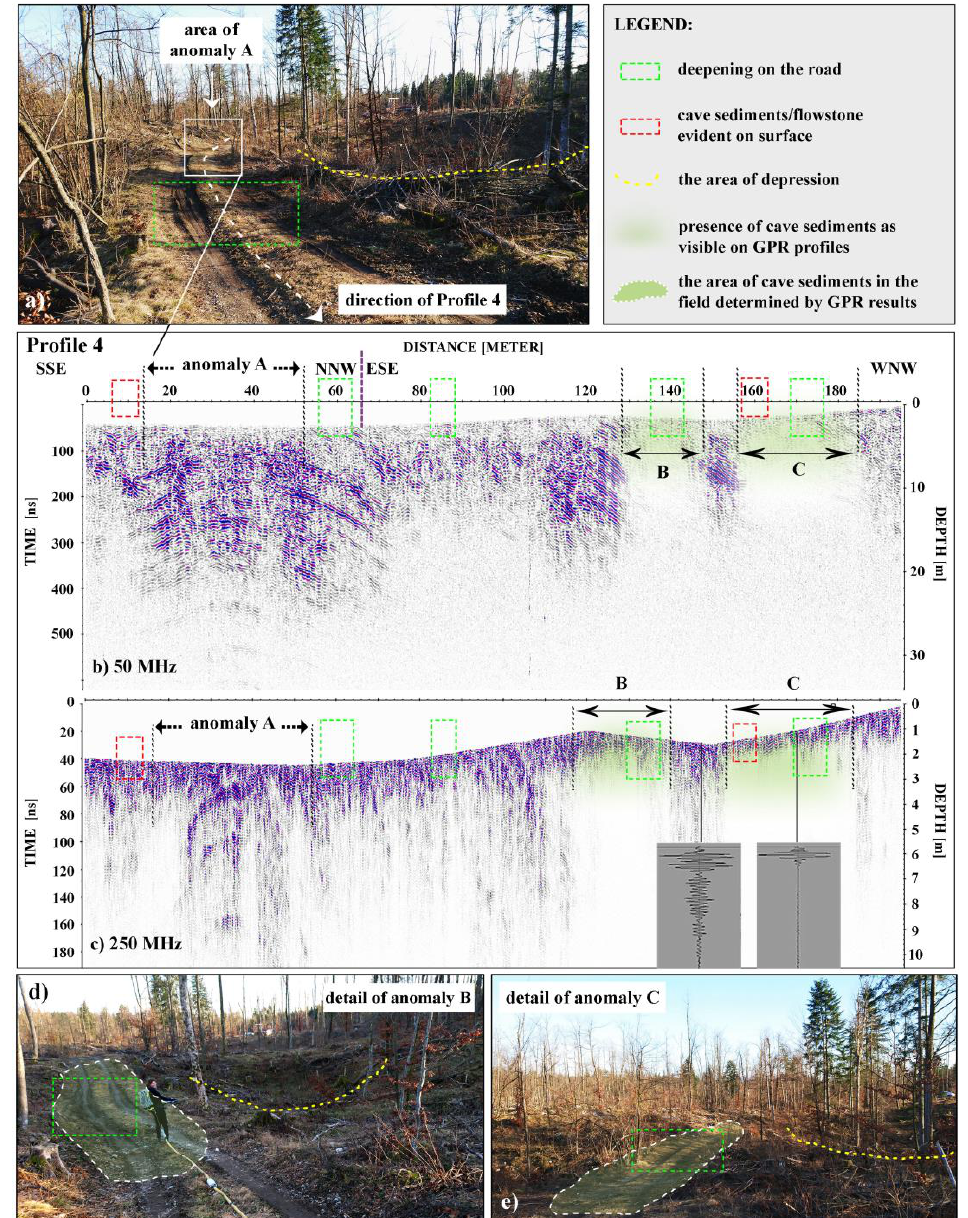
Figure 12. ( a ) The starting point and direction of Profile 4 with the surface depression which appears in the area of anomaly A detected by GPR. The surface deepening is also visible on the road; ( b ) The radargram conducted with the 50 MHz antenna with the detected anomaly A and attenuated areas B and C interpreted as cave sediments; ( c ) The radargram conducted with the 250 MHz antenna (note the vertical exaggeration 1:5) with a comparison of signal amplitudes, where the signal is strongly attenuated by the depth in the area of cave sediments even after the processing steps; ( d ) Surface morphology in the area of anomaly B, where the depression and the deepening on the road occur — the attenuated areas were interpreted as cave sediments; ( e ) The extent of cave sediments on the field as detected by GPR and the accompanying occurrences of the road deepening.